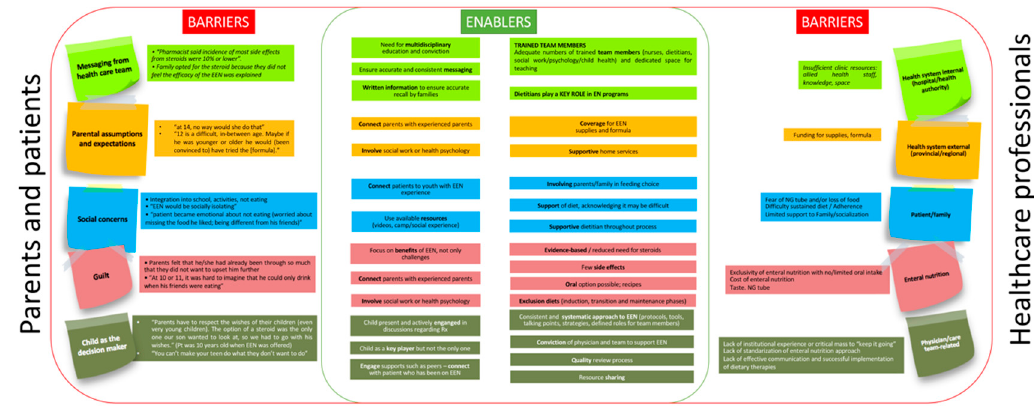
Figure 1. Barriers and facilitators of EEN. Adapted from [130–134].